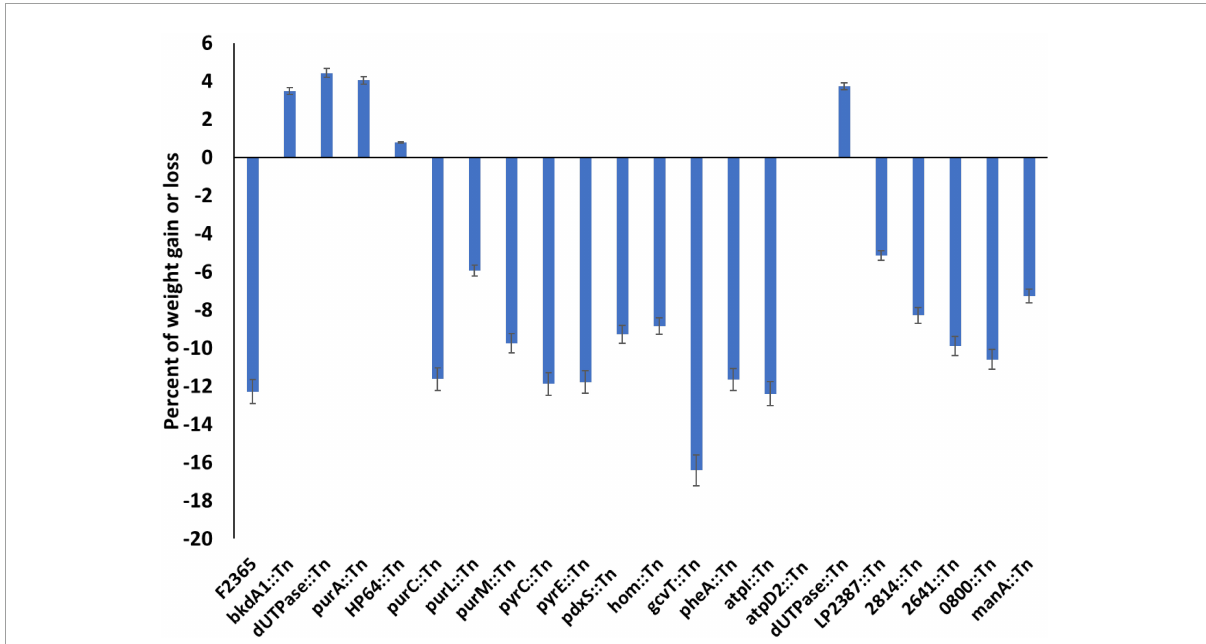
FIGURE3 Average changes in body weight in mice infected with Tn-mutants compared to mice infected with wild-type L. monocytogenes . Variation in body weight (gain or loss) was calculated by subtracting body weight of each mouse at end of experiment from the baseline body weight at the time of the injection. Values represent the mean of 5